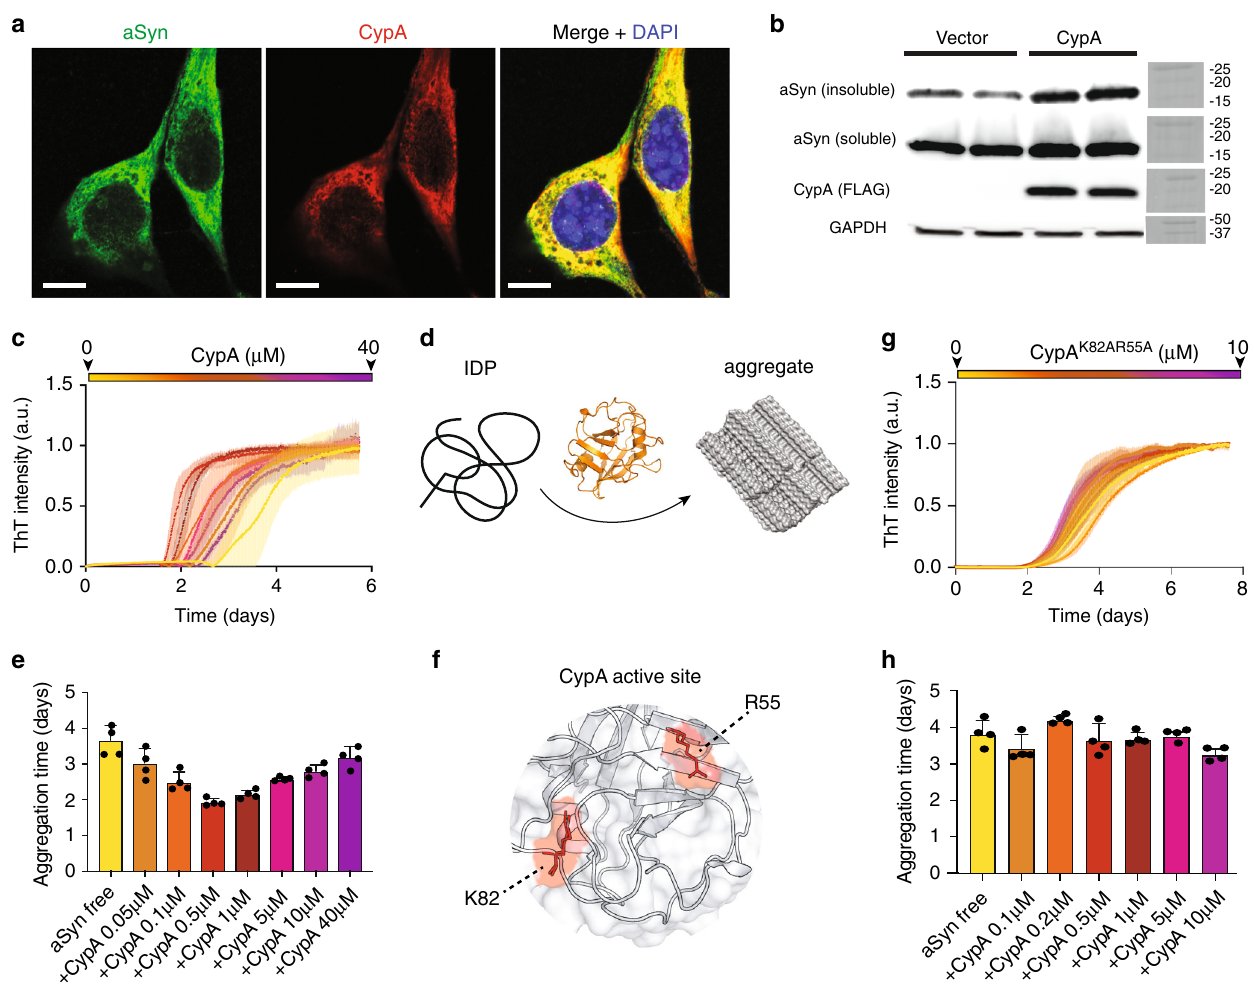
Fig. 1 CypA catalyzes aSyn aggregation. a HT-22 cells transfected with CypA and aSyn and stained for aSyn (green), CypA (red), and DNA (DAPI, blue) were imaged at 63× original magni fi cation using a confocal microscope. Scale bars represent 10 µ m. The images were acquired from n = 10 fi elds of 2 independent experiments. b , Western blots from HEK293T cells transfected for 72 h with aSyn, as well as empty vector or CypA plasmids expressing for 72 h following Sarkosyl-insoluble fractionation. n = 3 independent experiments were performed . c , g ThT- fi brillization assay of aSyn alone (30 μ M, green) and in the presence of increasing concentrations of wild-type CypA ( c ) or the functionally impaired R55A/K82A mutant of CypA ( g ). Data points represent the mean values from n = 4 independent experiments ±1 standard deviation (SD). d Schematic representation illustrating catalysis of IDP misfolding by CypA. The aggregate was prepared with PyMol v. 1.7.6.0 using aSyn amyloid fi brils (PDB code: 6A6B). e , h Aggregation half-times of aSyn alone (yellow), and in the presence of increasing concentrations of wild-type CypA ( e ) or the R55A/K82A mutant of CypA ( h ). Data points represent the mean values from n = 4 independent experiments ±1 SD. f 3D structures of the active site of CypA. R55 and K82, which are important for CypA activity, are highlighted in